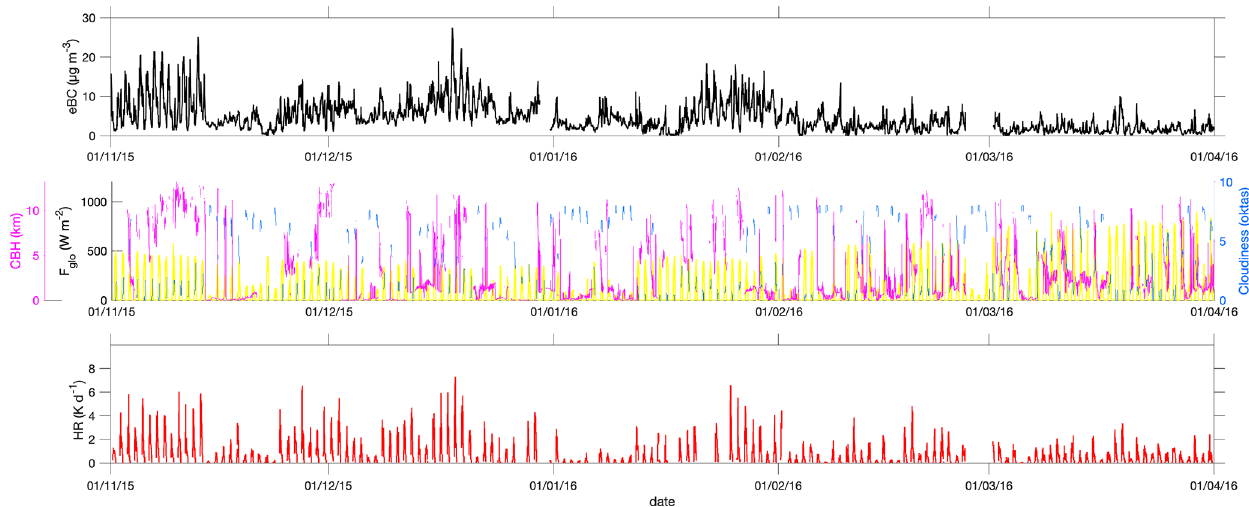
Figure 5. High-time-resolution data (5min) for eBC, global irradiance ( F glo , yellow line) cloud base height (CBH), cloudiness (oktas) and the related heating rate (HR) from 1 November 2015 to 1 April 2016. Table 2. Monthly averaged data and the confidence interval at 95% of temperature ( T ), pressure ( P ), equivalent black carbon (eBC), absorption coefficient ( b abs ) and heating rate (HR) divided into their direct (dir), diffuse (dif) and reflected (ref) components and, finally, global ( F glo ), direct ( F dir ), diffuse ( F dif ) and reflected ( F ref ) irradiances. Month Metric T P eBC ∗